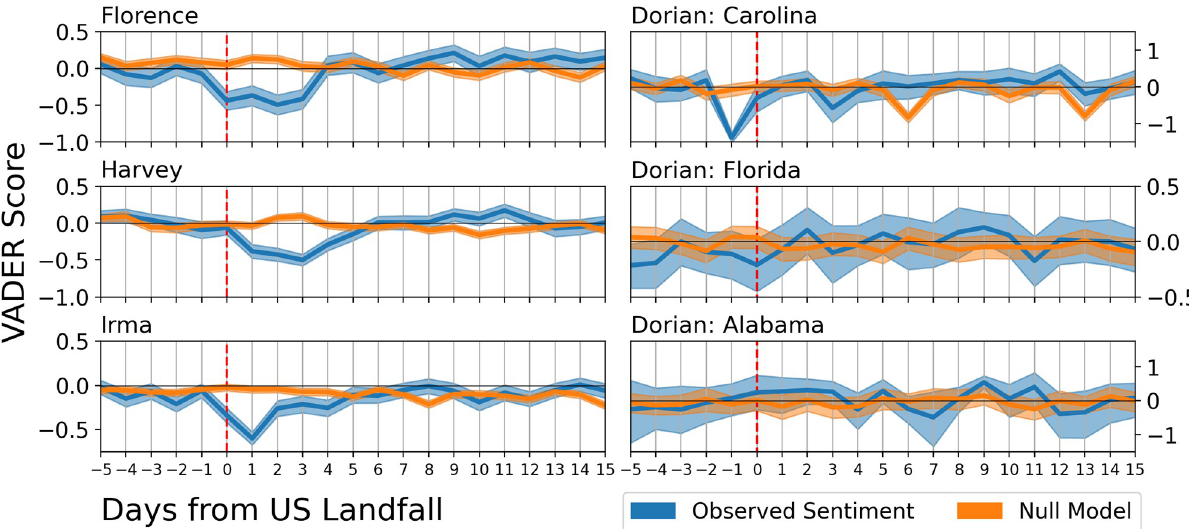
Fig 5. Bootstrapped VADER sentiment around each hurricane and location. For each day, we calculated the 2.5th, 50th, and 97.5th percentile of the bootstrapped sentiments in both the original data and the null model. The bold line is the median of the observed data and the null model while the shaded areas represent the 95% confidence interval. Any day in which the confidence intervals does not intersect represents a statistically significant change in sentiment. In all locations with landfall, the overall sentiment was lower when compared to the previous month. This was followed by 2–3 days of a sustained depressed sentiment. After about 8 days, the sentiment was statistically higher due to the emotional resilience of the community.